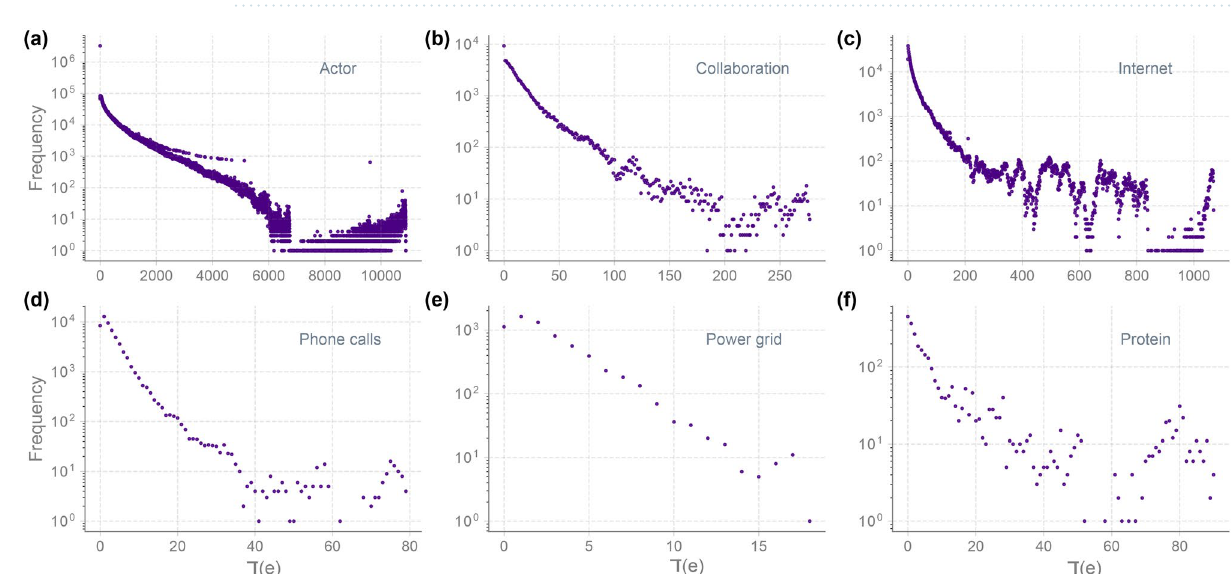
Figure 5. DD distributions in 6 undirected real-world networks. ( a ) Actor. ( b ) Collaboration. ( c ) Internet. ( d ) Phone calls. ( e ) Power grid. ( f )